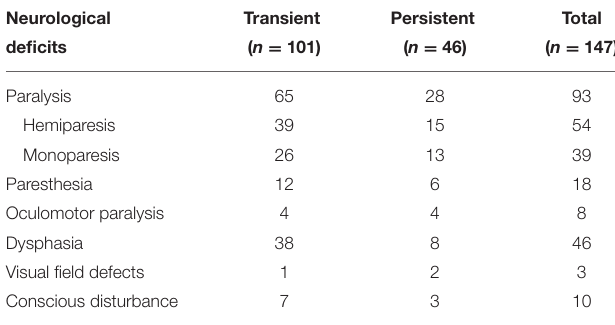
TABLE 2 | Detailed neurological